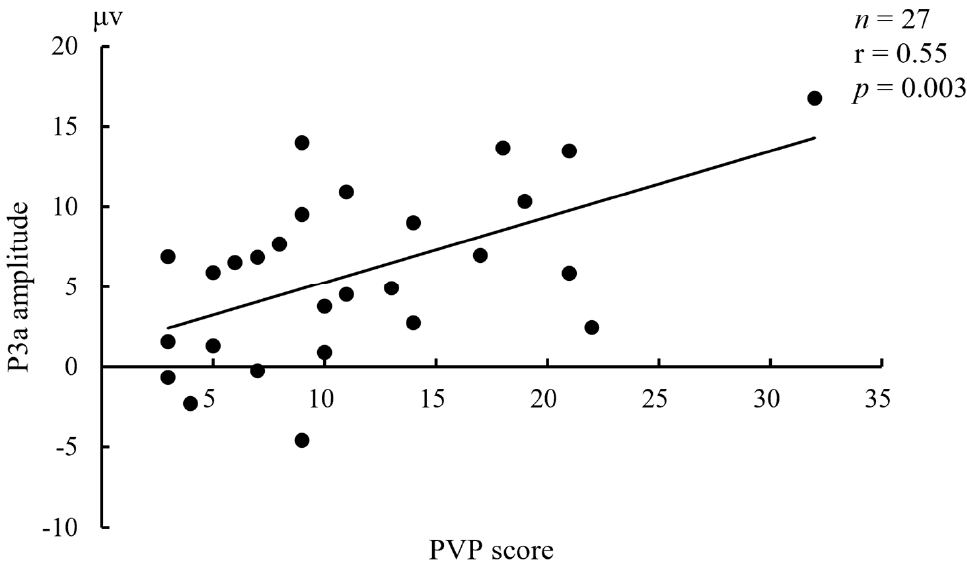
Figure 5. Relationship between P3a amplitude (Cz) under Erotica and the Plutchik–van Praag Depression Inventory (PVP) score in bipolar I disorder patients with hypersexuality.